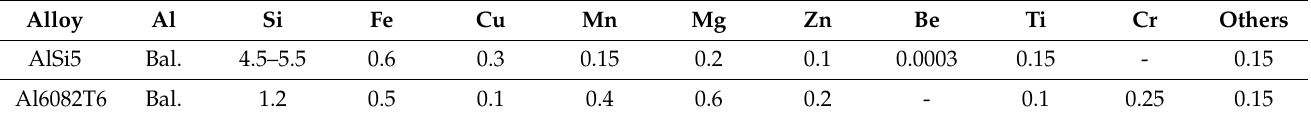
Table 1. Chemical composition of the substrate and the welding wire in wt%.